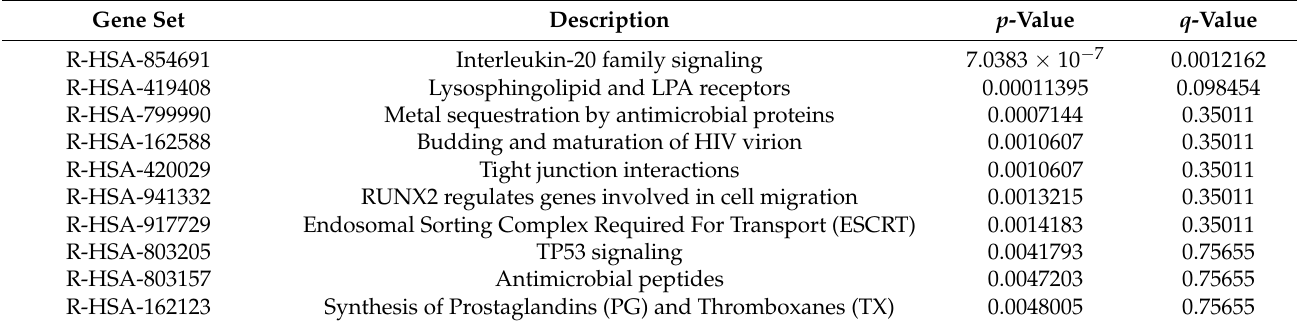
Table 1. Gene Set Enrichment Analysis (GSEA) from nearby host genes of retrotransposons.